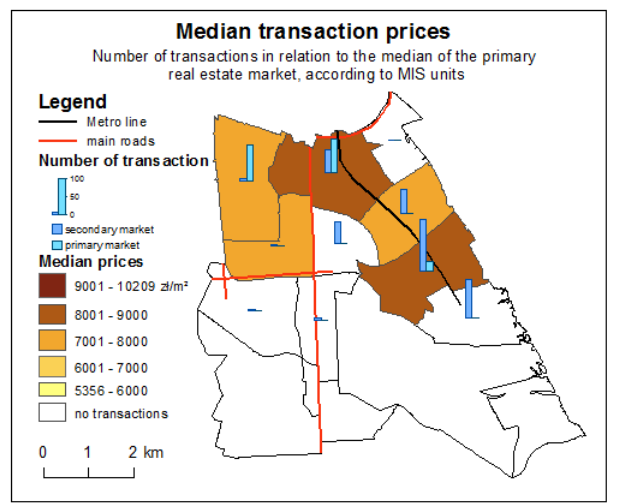
Fig. 9. Number of transactions on the primary and secondary residential real estate markets in Ursynów in relation to the median of the primary real estate market, according to MIS units